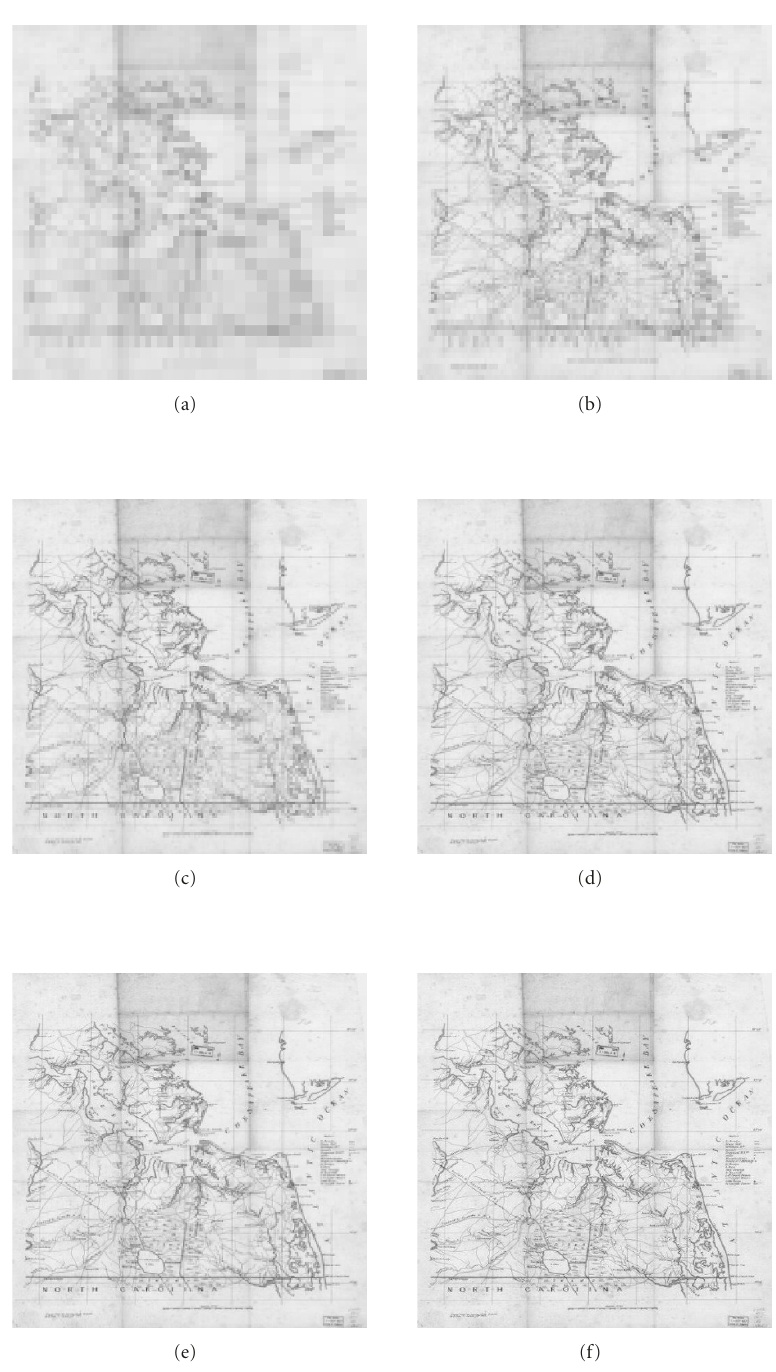
Figure 12: Progressive reconstruction of Military Map1 using any 4 out of 6 shadows and with the following percentages of coe ffi cients, and the resulting PSNR: (a) 1%, 21 . 38dB, (b) 5%, 23 . 72dB, (c) 15%, 25 . 73dB, (d) 25%, 28 . 27dB, (e) 50%, 32 . 15dB, (f) 100%,